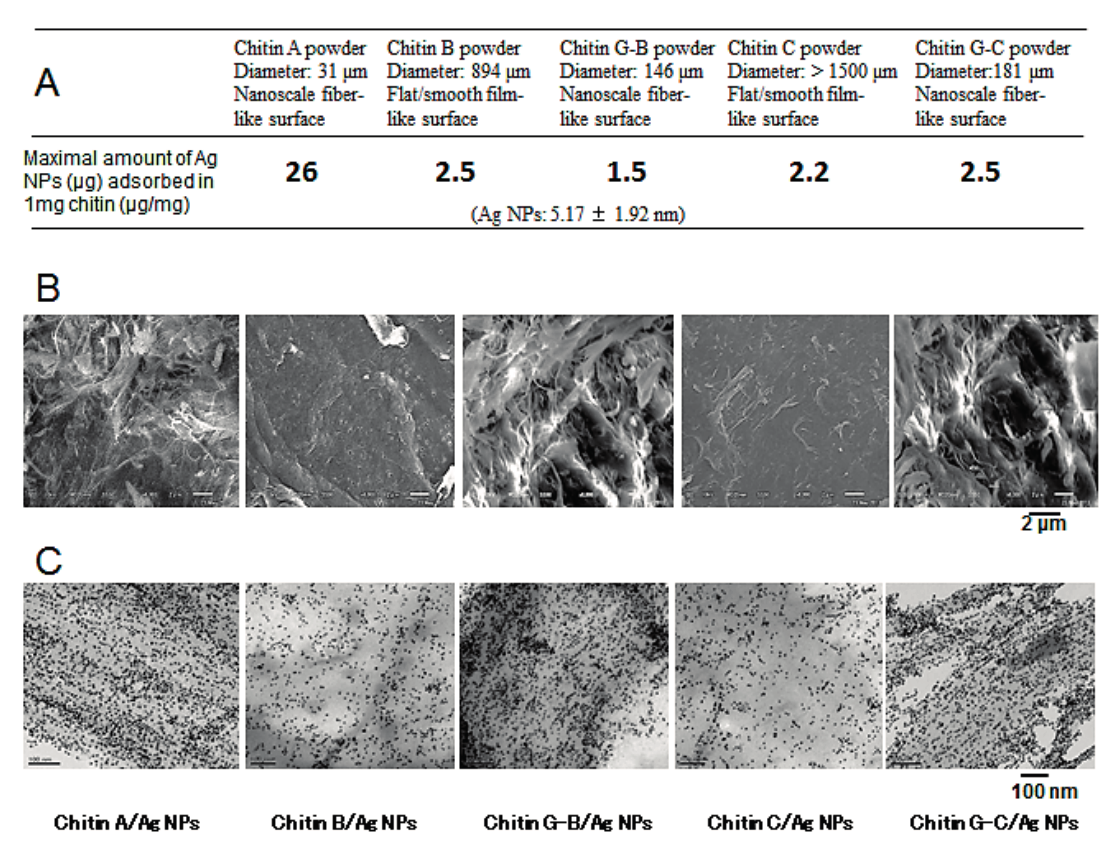
Figure 2. Interactions of Ag NPs with chitins comprising nanoscale fiber-like or flat/smooth film-like surface structures. ( A ) Binding of Ag NPs onto each chitin; ( B ) SEM micrographs of each chitin powder; ( C ) TEM micrographs of each chitin-Ag NP composite. A total of 1mg of each chitin was added to a 10 μ g/mL suspension of Ag NPs and mixed for 30 min prior to